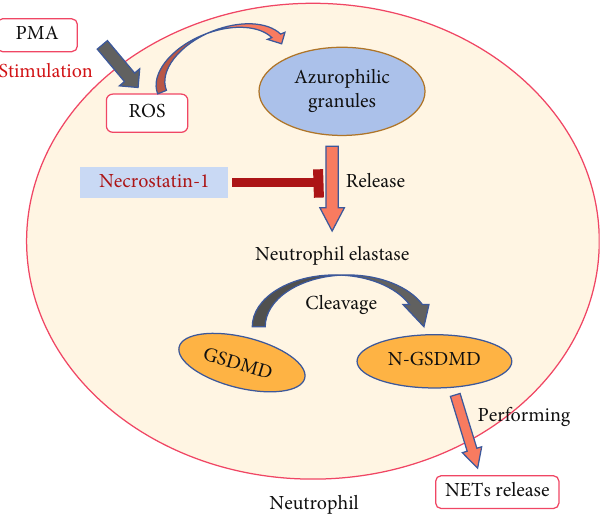
Figure 6: Schematic illustration of Necrostatin-1 (Nec-1) ameliorating di ff use alveolar haemorrhage in systemic lupus erythematosus by inhibiting the activation of neutrophil elastase (NE)/N-GSDMD to prevent neutrophil extracellular trap (NET)